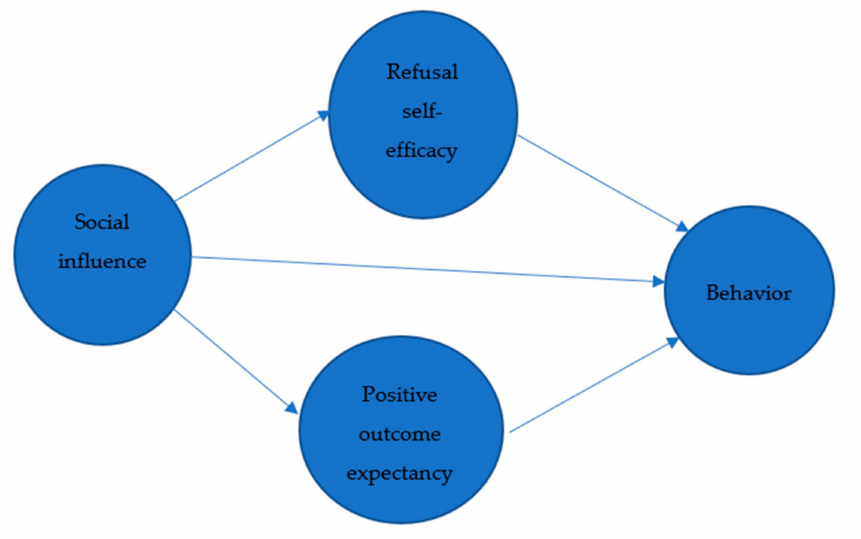
Figure 1. The theoretical model of social cognitive theory. FoMO: fear of missing out; SNS use: Social networking sites use. References 14,15,16 are missing. Please revise references in numerical